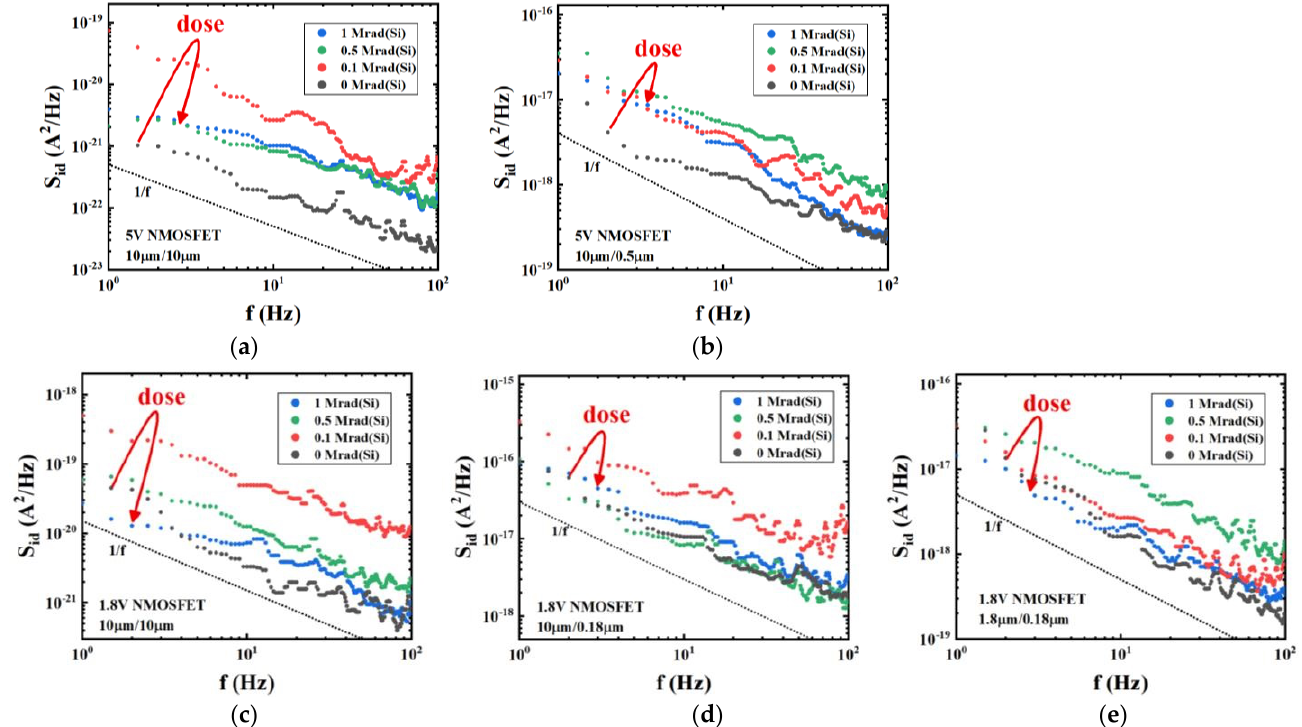
Figure 6. Drain-current noise power density spectrum of 5 V NMOSFETs for geometries: ( a ) W / L = 10 μm/10 μm and ( b ) W / L = 10 μm/0.5 μm and 1.8V NMOSFETs for geometries: ( c ) W / L = 10 μm/10 μm, ( d ) W / L = 10 μm/0.18 μm and ( e ) W / L = 1.8 μm/0.18 μm at different irradiation doses. All devices were irradiated up to 1 Mrad(Si) under the “on” bias condition. Noise measurements were carried out when V gs − V th = 0.3V and V ds = 0.1V.